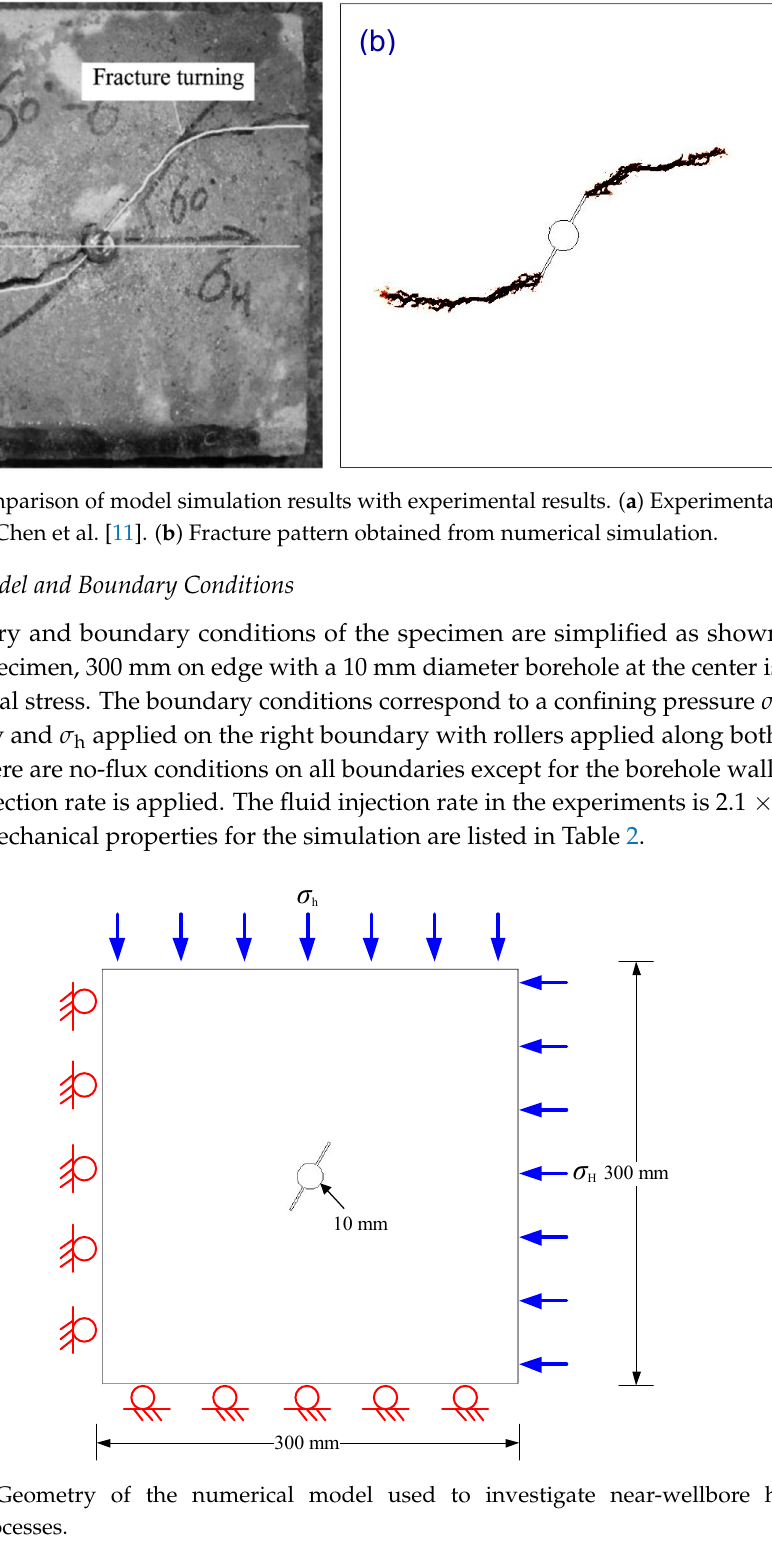
Figure 6. Geometry of the numerical model used to investigate near-wellbore hydraulic fracturing processes.